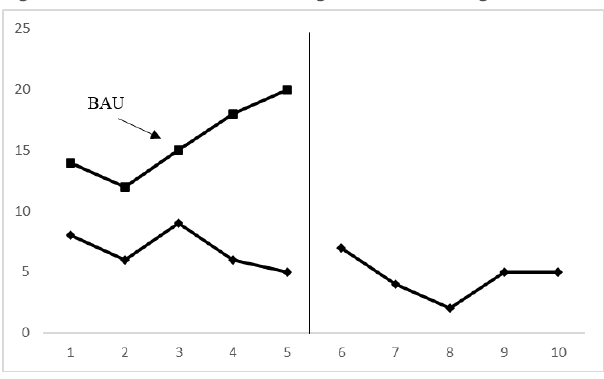
Figure 3. Data From an Alternating Treatment Design